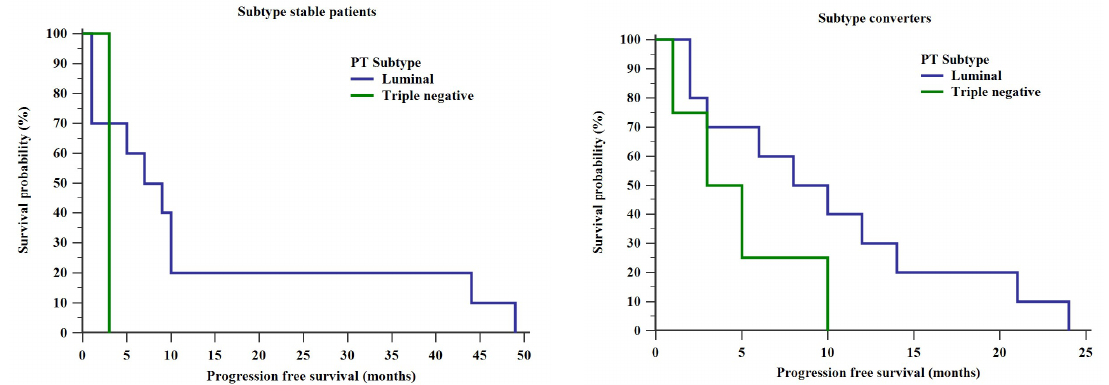
Figure 2. Differences in PFSs between different primary tumors (PT) subtypes in subtype stable patients and subtype converters .